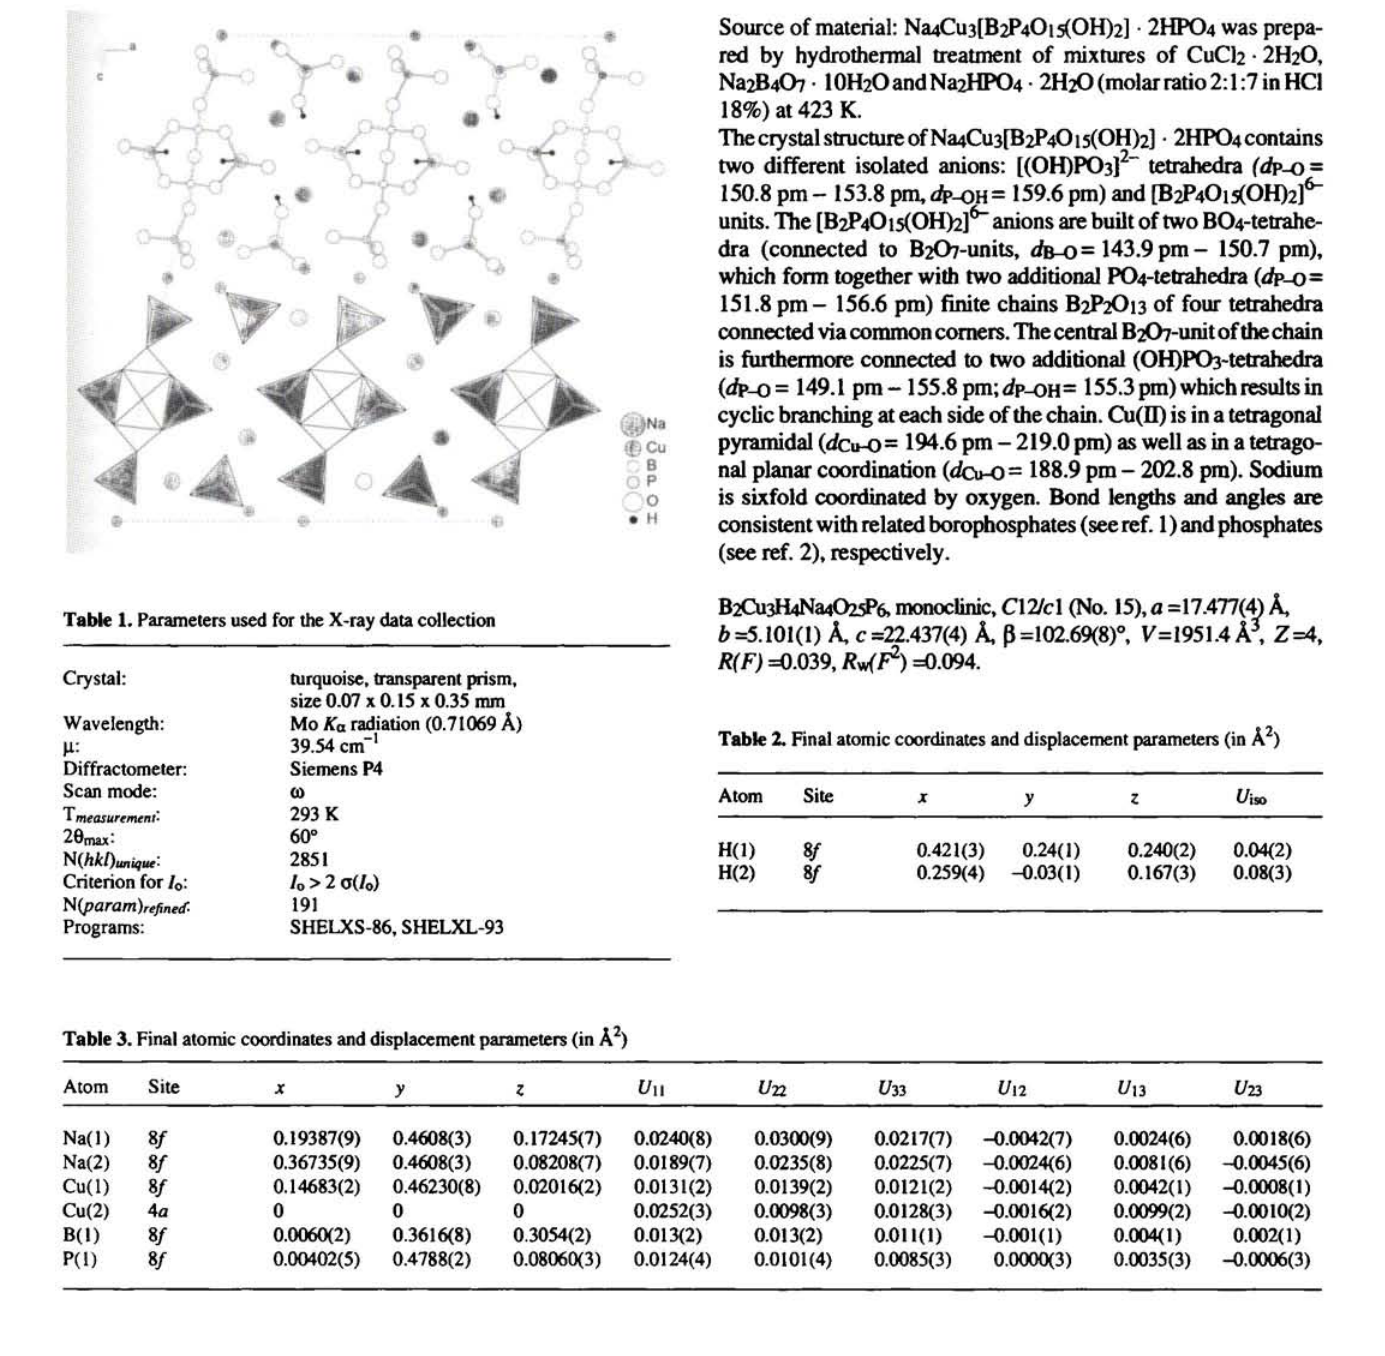
Table 3. Final atomic coordinates and displacement parameters (in Â^)